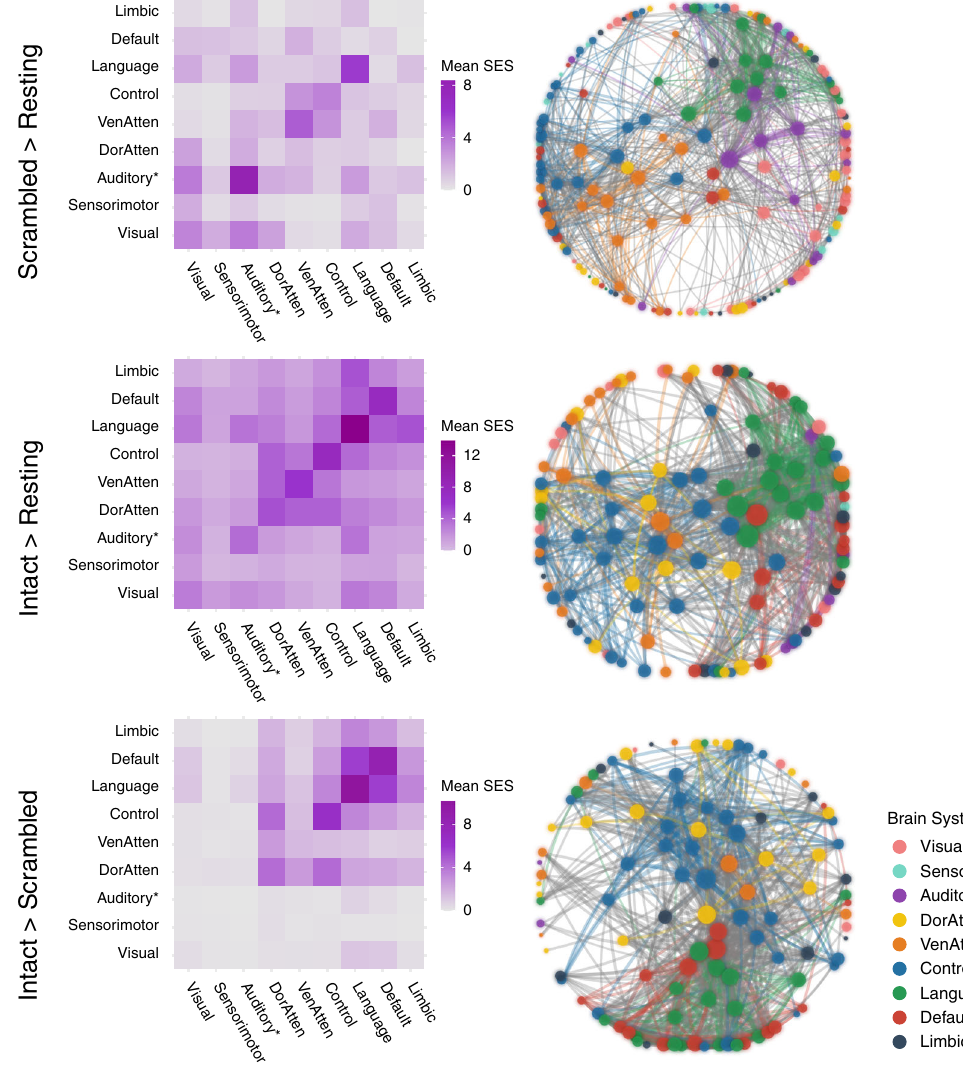
Fig. 4 Network recon fi guration for narrative comprehension. The fi gure illustrates the signi fi cant ISFC difference ( P < 0.05, FWE corrected) between the scrambled-narrative condition and the resting-state condition (the fi rst row), the intact-narrative condition and the resting-state condition (the second row), and the intact- and the scrambled-narrative conditions (the third row). The left column shows the distribution of all the signi fi cant functional couplings of each contrast within and between brain systems. Each cell indicates the mean standardized effect size (SES) of each contrast, i.e., the ratio between the sum of the SES and the number of the edges in the fully connected situation. The right column shows the network layout, where the nodes represent the brain areas, and the edges represent the signi fi cant interregional ISFC differences between conditions. This layout was generated using the force-directed graph drawing algorithm: strongly connected nodes are clustered together, and weakly connected nodes are pushed apart. For clarity, we just included the top 995 signi fi cant edges with the largest SES (i.e., network density equals 5%, as there were 19900 potential edges). The size of the nodes denotes the node degree of each brain area. The color of the nodes denotes to which brain system they belong. The width of the edges denotes the SES. Intra-system edges are in the color of that network; inter-system edges are in gray. “ Auditory* “ denotes the network including not only the auditory cortex but also the ventral somatosensory and motor brain areas corresponding to the body parts above the neck. VenAtten = ventral attention; DorAtten = dorsal